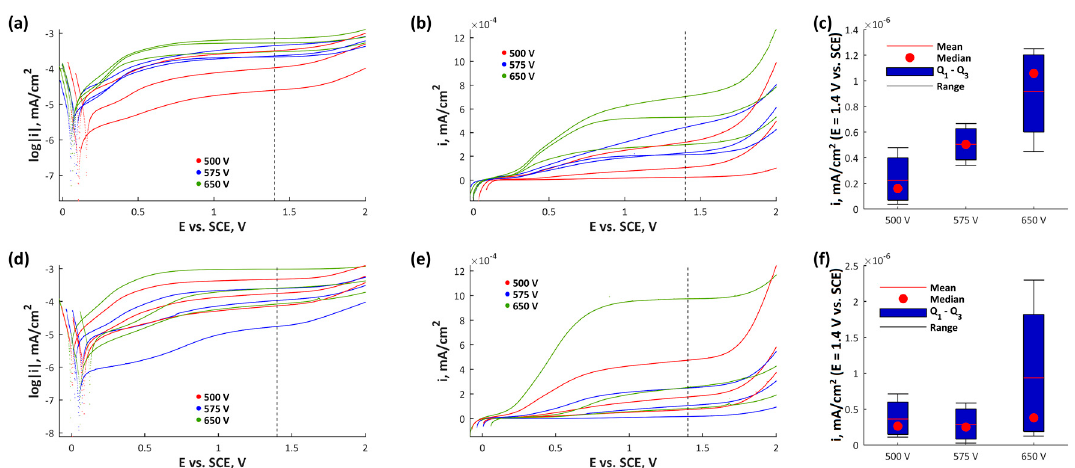
Figure 8. Potentiodynamic corrosion results of the porous coating formed on CP Titanium Grade 2 after PEO treatment at voltages of 500 V DC (red lines), 575 V DC (blue lines), and 650 V DC (green lines), in ( a ) magnesium-rich, or ( b ) zinc-rich phosphoric acid electrolytes; ( a , d ) logarithmic Y axis; ( b , e ) linear Y axis; ( c , f ) statistical analysis results.